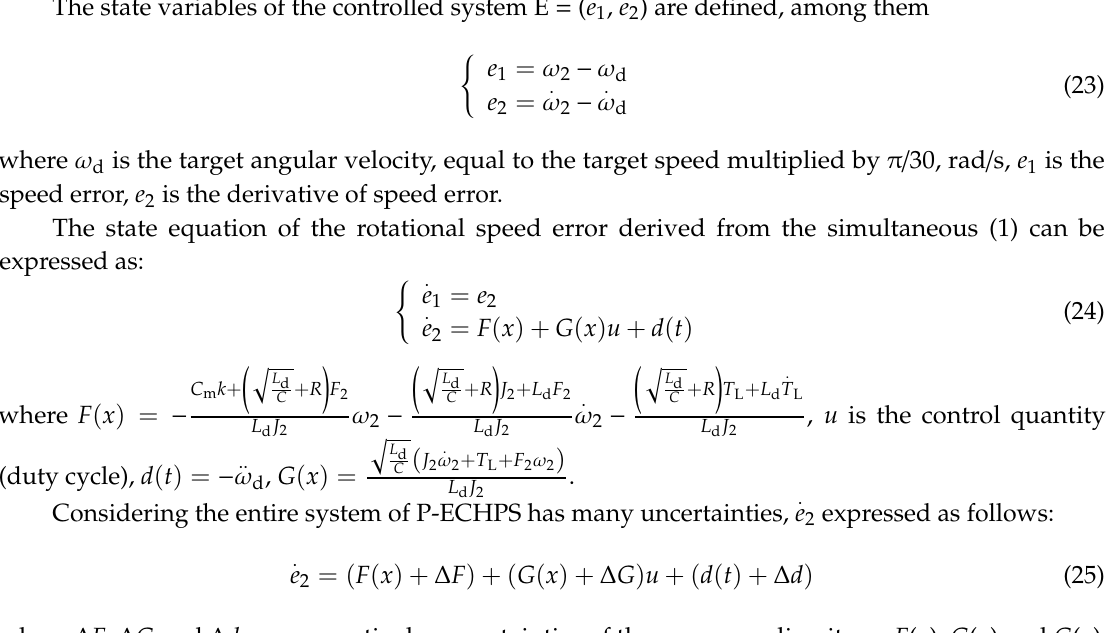
Figure 10. The diagram of PMSC inner rotor target speed.